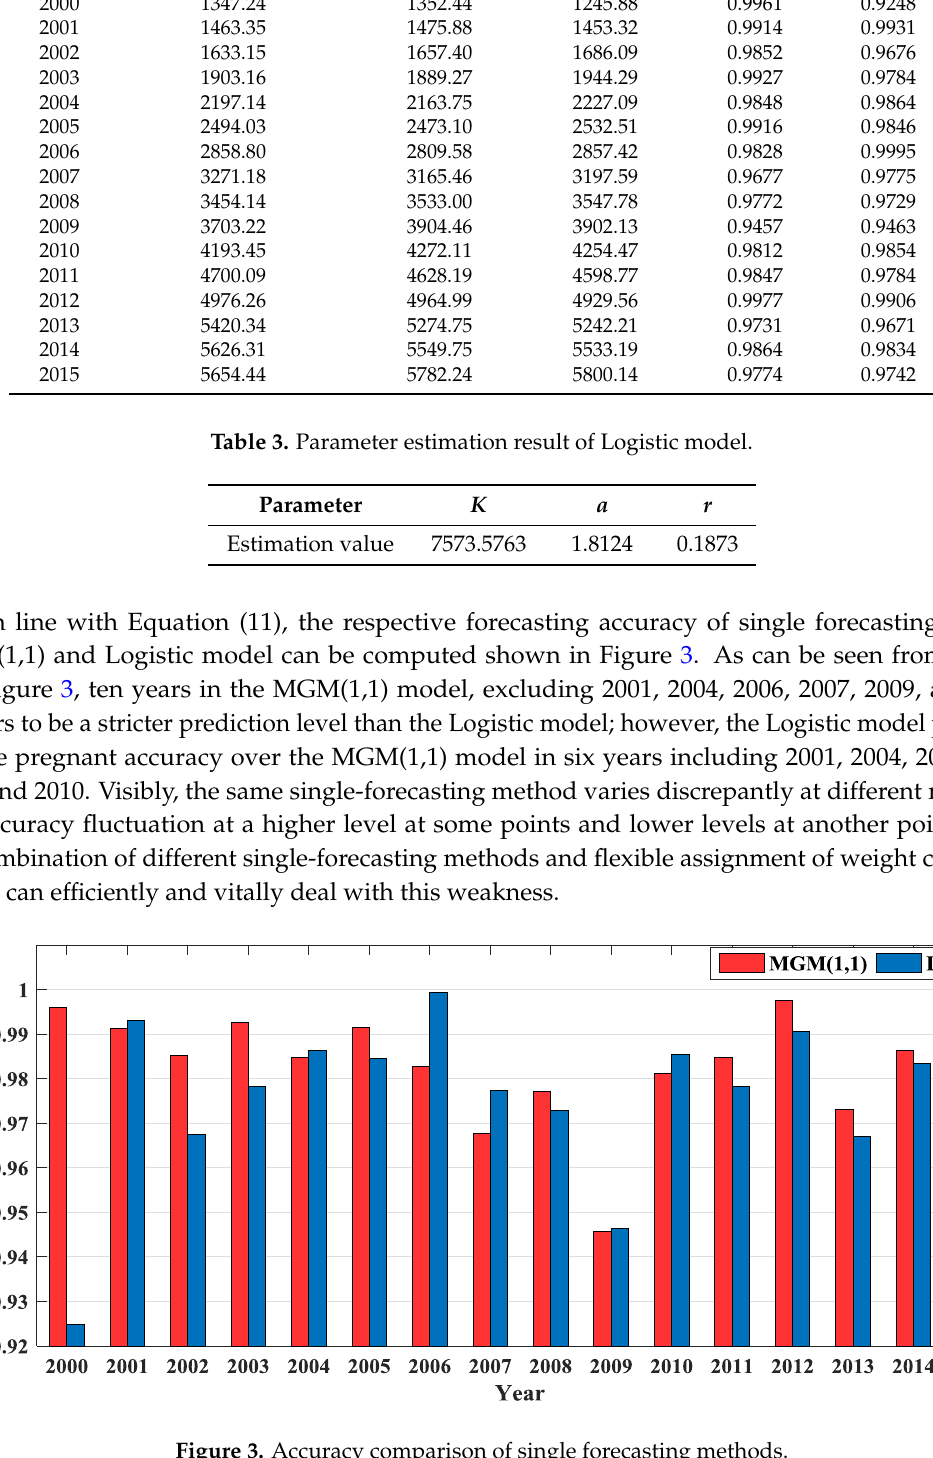
Table 2. S ingle forecasting results.